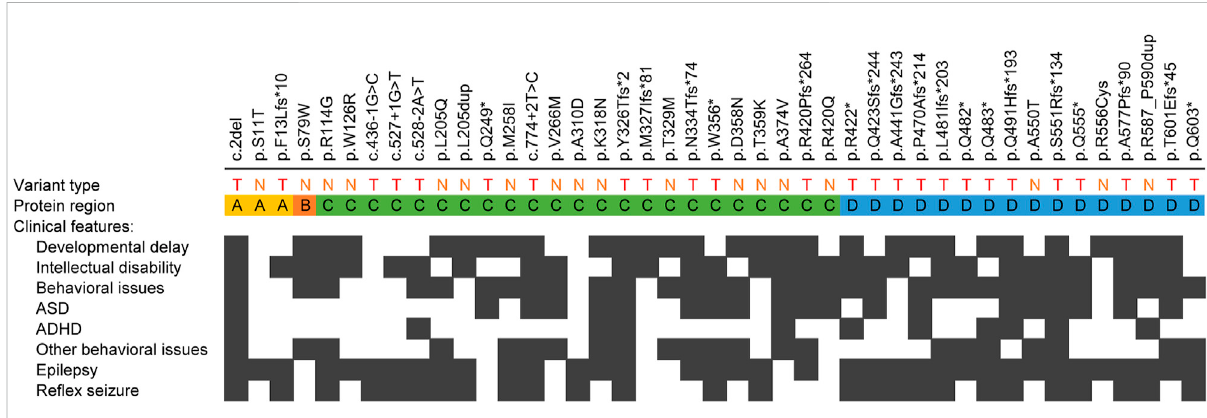
FIGURE 5 Combinedclinicalfeaturesobservedinpatientswithspeci fi c SYN1 variants.T:truncatingvariants(nonsense,frameshiftandsplicingvariants);N: non-truncating variants (missense substitutions and in-frame duplications). Black squares indicate that a given clinical feature was described in association with the corresponding variant. The protein region has been subdivided in the four protein domains affected by the variants, namely domains A-D. No association can be detected between the position of the variant and the presence of a given clinical